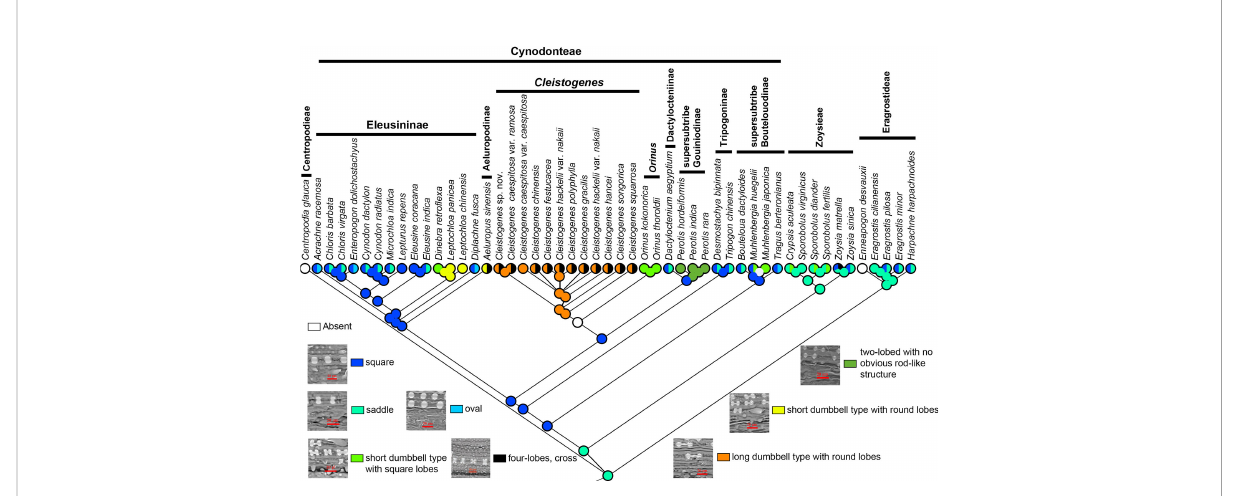
FIGURE 6 Ancestral state reconstruction of phytoliths in Chloridoideae. The differently coloured spots at the nodes indicate the different character